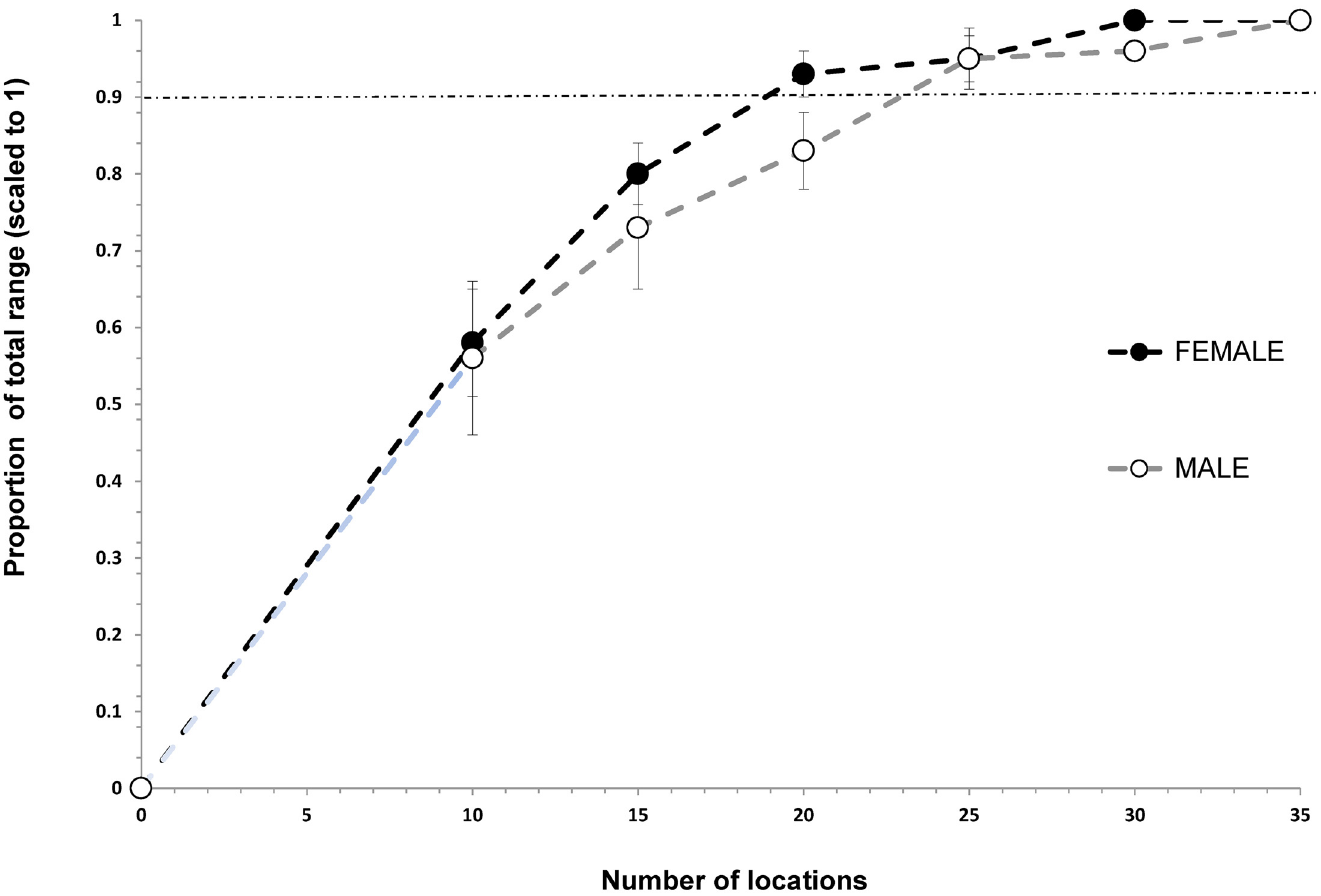
Fig 5. Incremental 95% MCP accumulation curve showing the number of locations required to more accurately estimate the wet season (Oct-Mar) home ranges for black rhino in Hluhluwe-iMfolozi Park (HiP), South Africa. Note that the horizontal dashed line represents the within 10% level of the total home range recommended for increased